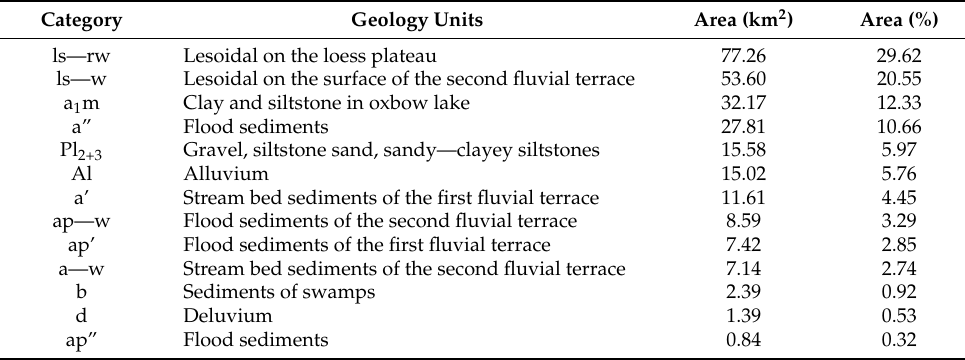
Table 7. Geology units over the research area and their area expressed in km 2 and